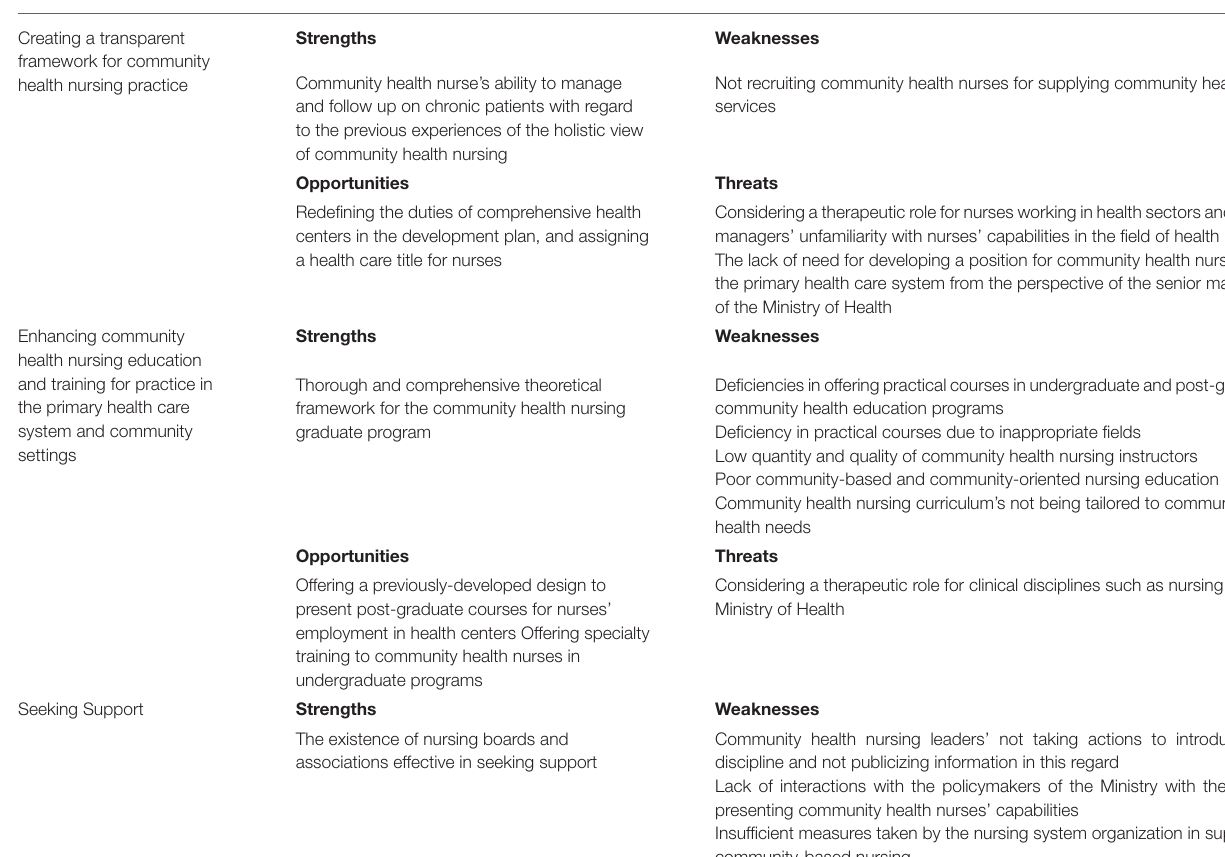
TABLE 3 | A summary of the statements of the SWOT analysis based on 4 subcategories. Main